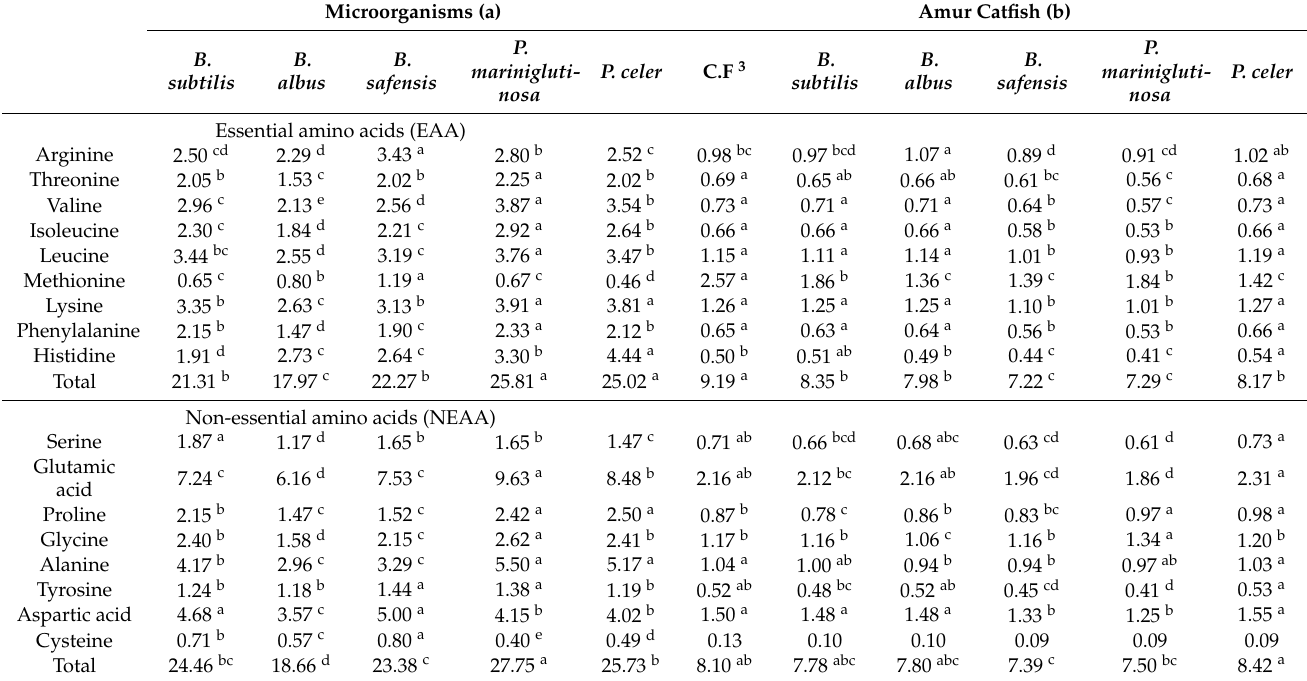
1 Values are means from triplicate groups of shrimps where the values in each row with different superscripts are significantly different ( p < 0.05). 2 Dry matter basis. 3 Wet weight basis. 4 Commercial feed containing 47.44% protein and 5.65% lipid, Korea. The amino acid compositions of the microorganisms and fish fed with the commercial and microbial-supplemented diets are provided below (Table 3). As for the amino acid com- positions of the microorganisms (Table 3a), all of the strains were found to contain the high- est amounts of leucine ( B. subtilis ), lysine ( B. albus and Pseudoalteromonas mariniglutinosa) , arginine ( B. safensis ), and histidine ( Psychrobacter celer ) with the least amounts of methionine in essential amino acids (EAA); and, all of the strains were found to contain the highest amounts of glutamic acid with the least amounts of cysteine in non-essential amino acids (NEAA). For the fish fed with the commercial and microbial-supplemented diets (Table 3b), the highest and least amounts were methionine and histidine in the EAA, and glutamic acid and cysteine in the NEAA, in all of the groups. Table 3. Amino acid compositions of bacterial strains and Amur catfish fed with commercial feed and 5% freeze-dried bacteria biomass-supplemented feed at end of 8-week experiment (%) 1,2 .